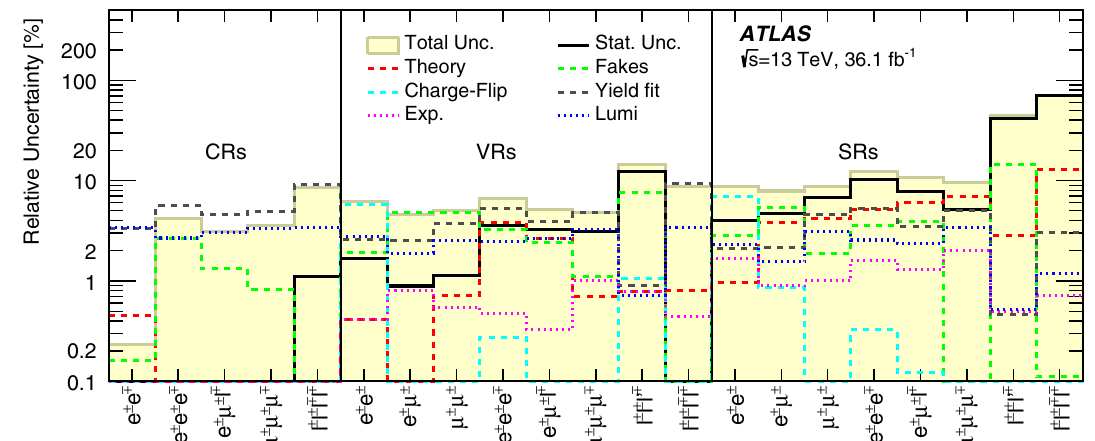
Fig. 6 Relative uncertainties in the total background yield estimation after the fit. ‘Stat. Unc.’ corresponds to reducible and irreducible back- groundstatisticaluncertainties.‘Yieldfit’correspondstotheuncertainty arising from fitting the yield of diboson and Drell–Yan backgrounds. ‘Lumi’ corresponds to the uncertainty in the luminosity. ‘Theory’ indi- catesthetheoreticaluncertaintyinthephysicsmodelusedforsimulation